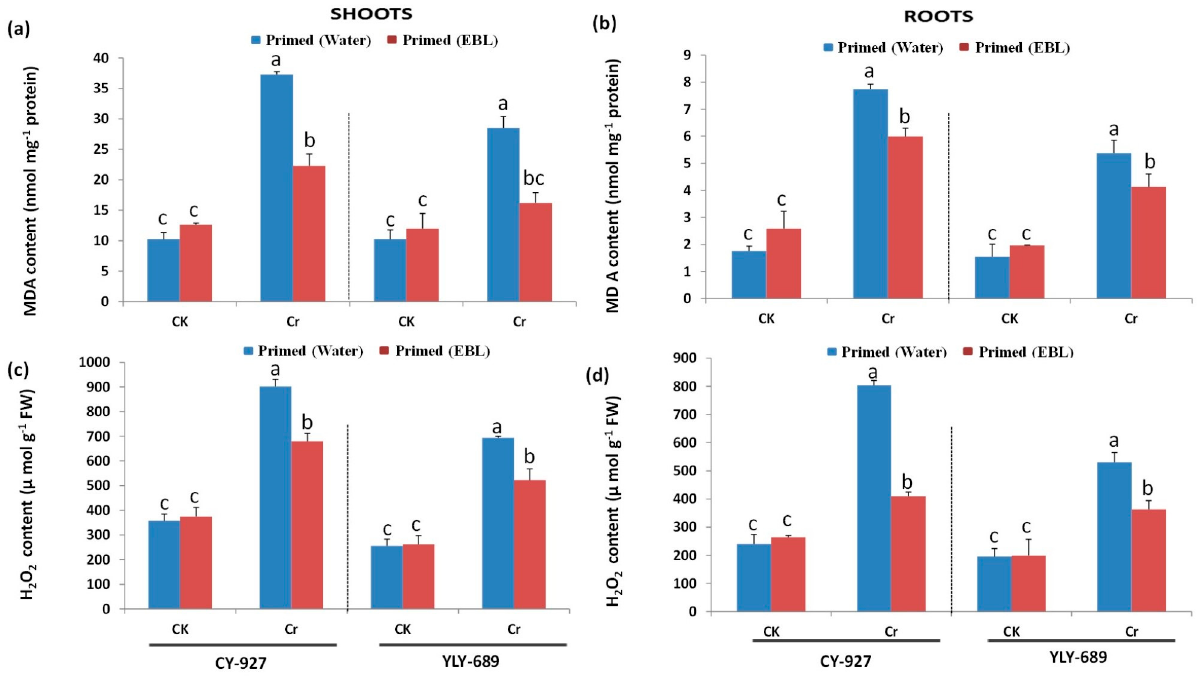
Figure 3. Effect of Cr toxicity on MDA contents as well as H 2 O 2 production and alleviation behavior of EBL toward MDA contents and H 2 O 2 production under Cr stress in both varieties of rice. ( a ) MDA contents in shoots of both rice cultivars; ( b ) MDA contents in roots of both rice cultivars; ( c ) H 2 O 2 contents in shoots of both rice cultivars; ( d ) H 2 O 2 contents in roots of both rice cultivars. The values presented are means ± SDs ( n = 3). Different letters (a–c) above bars show a significant difference at p < 0.05 among treatments.